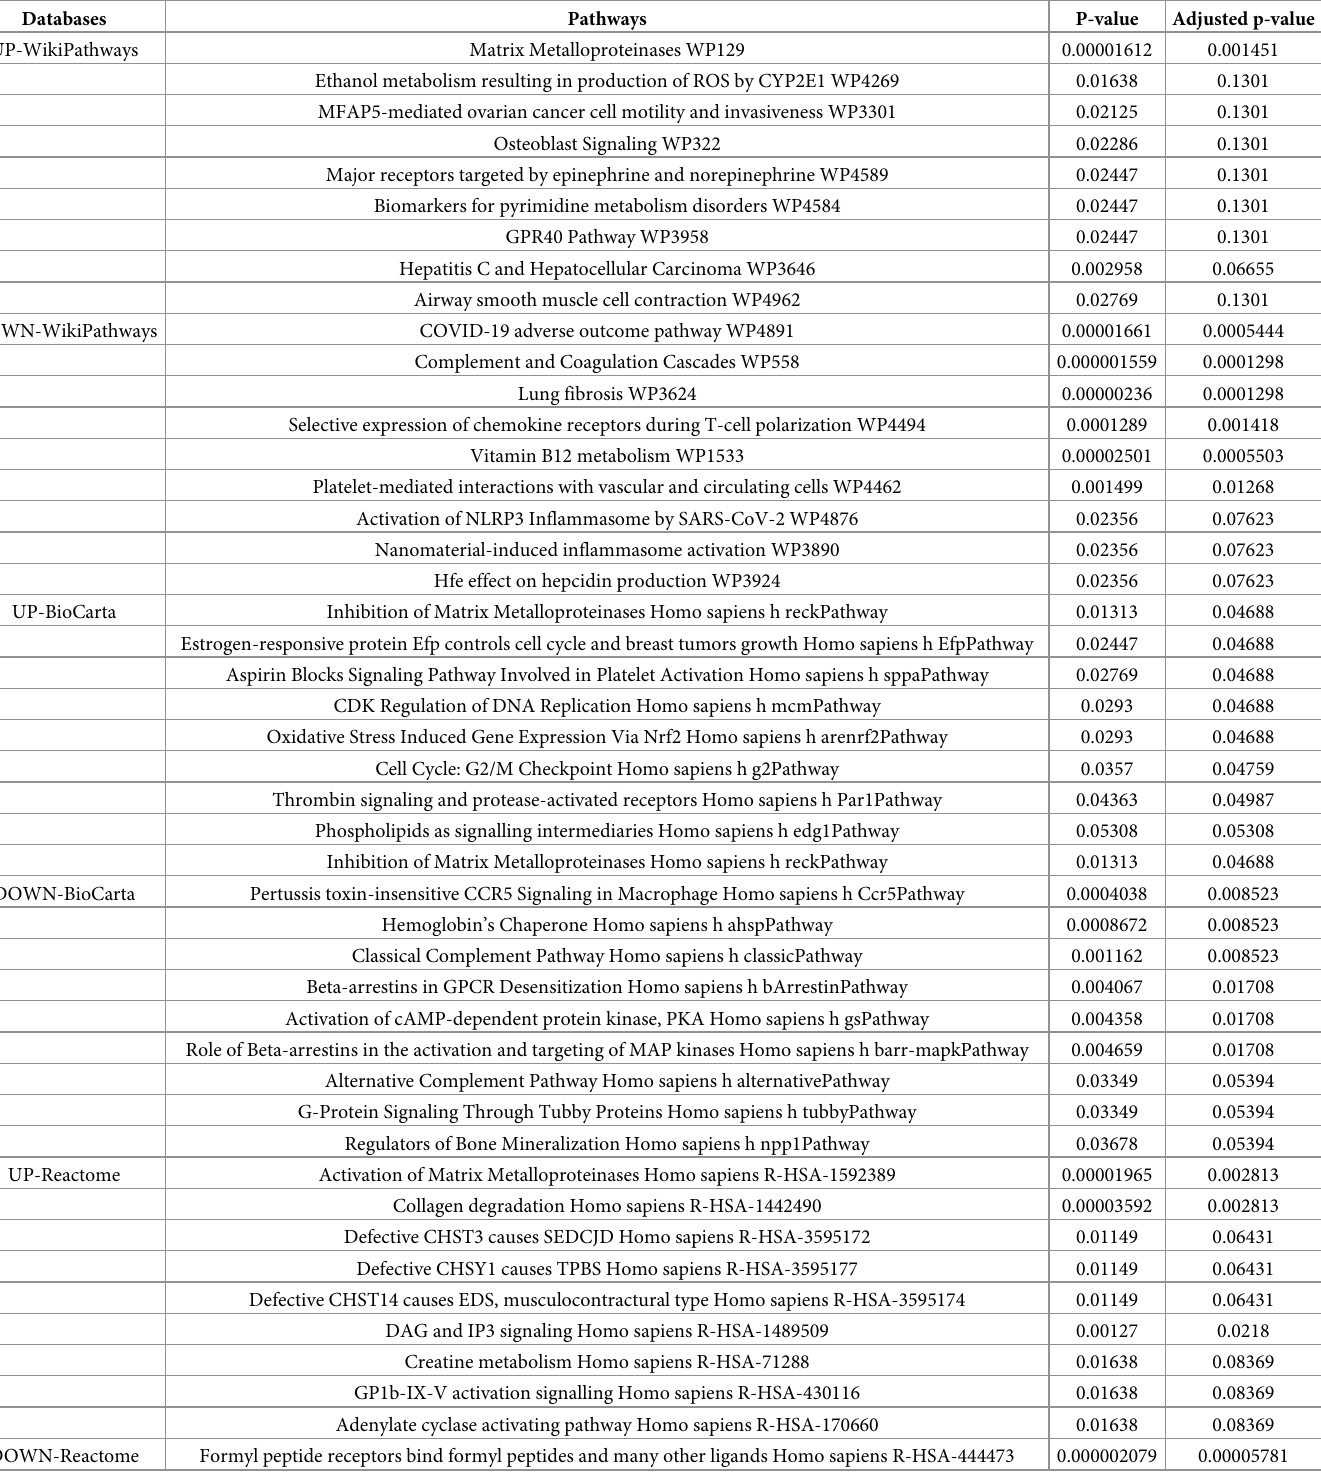
Table 3. Top 9 pathways from WikiPathways, BioCarta and Reactome databases for common up-regulated DEGs and common down-regulated DEGs among COVID-19 and